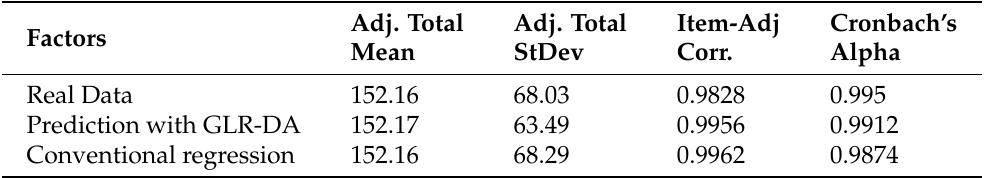
Table 7. Summary analysis.